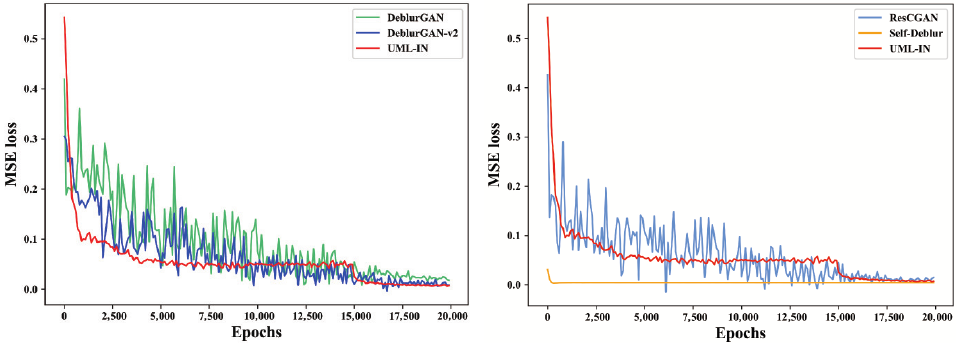
Figure 6. Generate convergence curves of each model on the GoPro